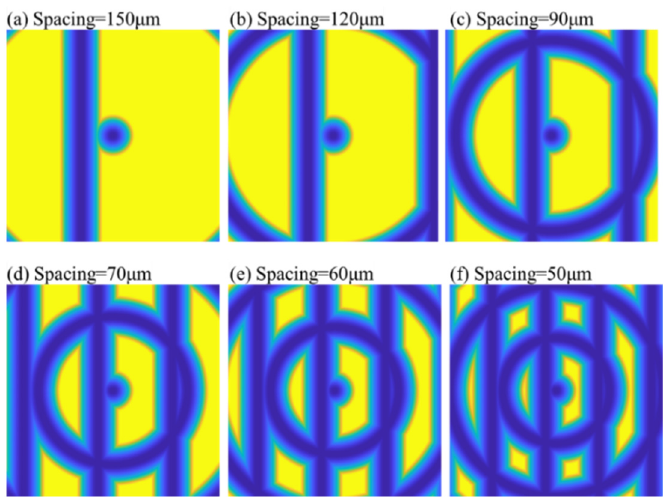
Figure 18. Comparison of simulated surface topography of a polar microstructure with different groove spacing. Other important machining parameters: depth of cut: 5 μ m, tool nose radius: 50 μ m.